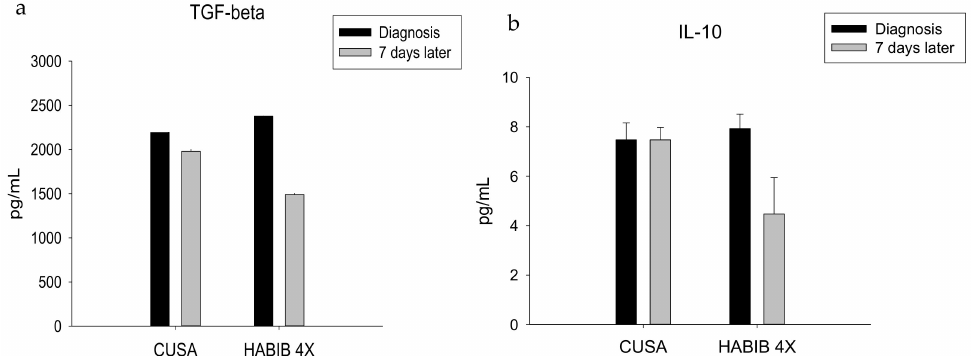
Figure 5. Serum TGF-ß ( a ) and IL-10 ( b ) level changes in both study groups. Significant decrease was noted in Habib TM 4X group.